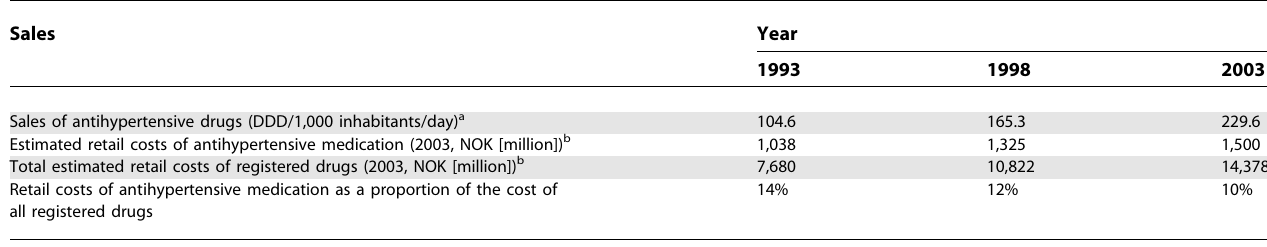
Table 1. Sales of Antihypertensive Drugs in Norway 1993–2003